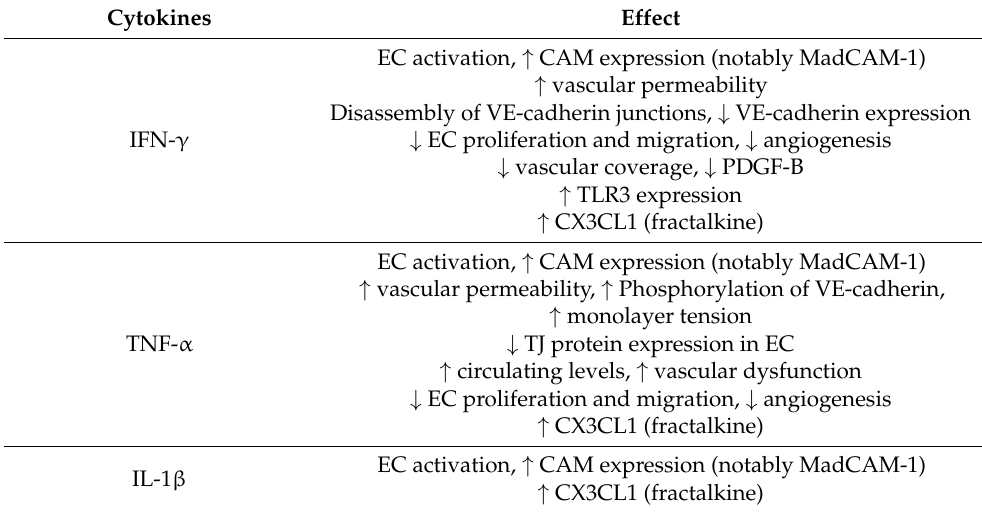
Table 2. Vessel-directed effects of key inflammatory cytokines involved in the pathogenesis of IBD. Cytokines Effect EC activation, ↑ CAM expression (notably MadCAM-1) ↑ vascular permeability Disassembly of VE-cadherin junctions, ↓ VE-cadherin expression ↓ EC proliferation and migration, ↓ angiogenesis IFN- γ ↓ vascular coverage, ↓ PDGF-B ↑ TLR3 expression ↑ CX3CL1 (fractalkine) EC activation, ↑ CAM expression (notably MadCAM-1) ↑ vascular permeability, ↑ Phosphorylation of VE-cadherin, ↑ monolayer tension ↓ TJ protein expression in EC TNF- α ↑ circulating levels, ↑ vascular dysfunction ↓ EC proliferation and migration, ↓ angiogenesis ↑ CX3CL1